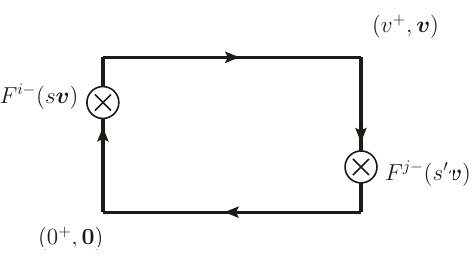
Figure 7 . Diagrammatic representation of the x -dependent unintegrated gluon distribution (x- uPDF) defined in eq.